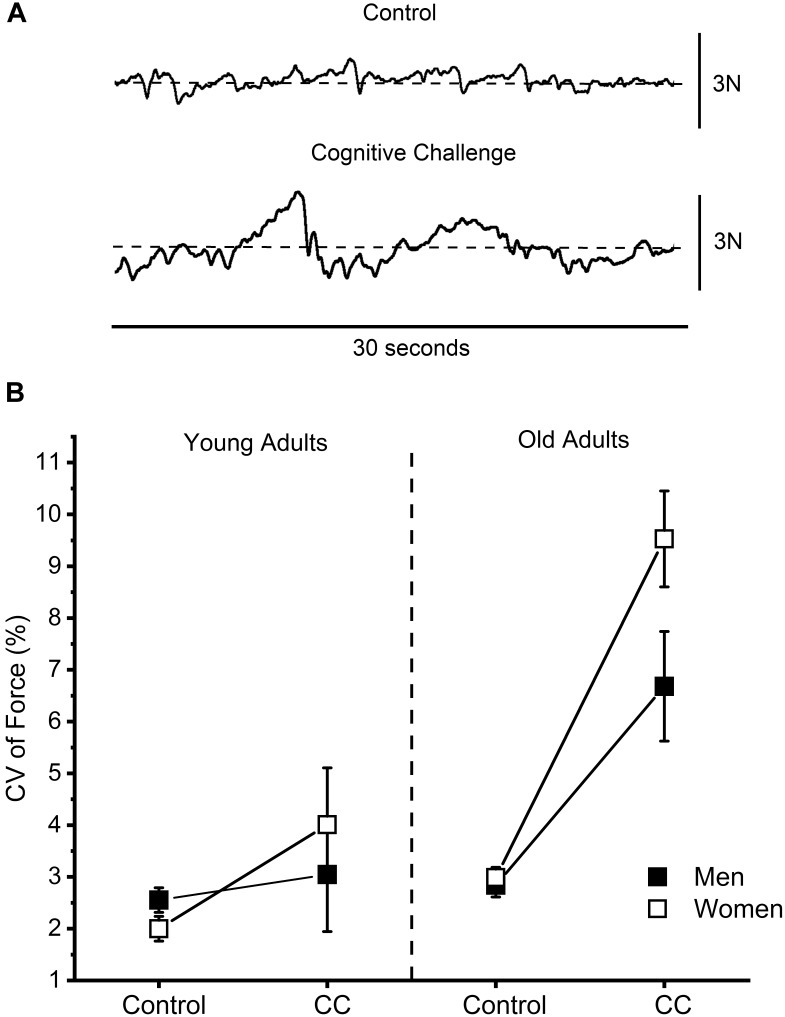
(A) Representative force signals of the elbow flexor muscles for control and cognitive challenge trials (subtracting by 13 from a four-digit number). (B) Force steadiness quantified as the coefficient of variation (CV) of force during the control and cognitive challenge trials (CC) of young and older men and women. Older adults had a greater increase in CV of force (i.e., reduced force steadiness) during the CC trials than young adults (P < 0.001) and women had a greater increase in CV of force during the CC trials than men (P = 0.03).